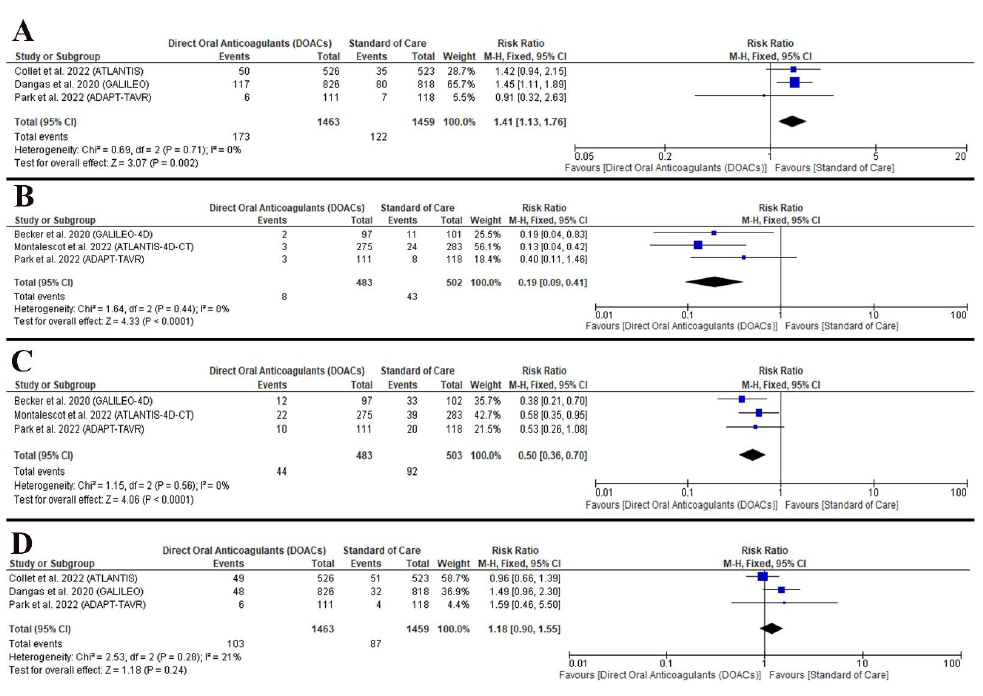
Figure 4. Forest plot of the secondary outcomes (( A ) the composite mortality, MI, and stroke/TIA; ( B ) RLM; ( C ) HALT; ( D ) major or life-threatening bleeding). RR: risk ratio, CI: confidence interval [5 – 9].